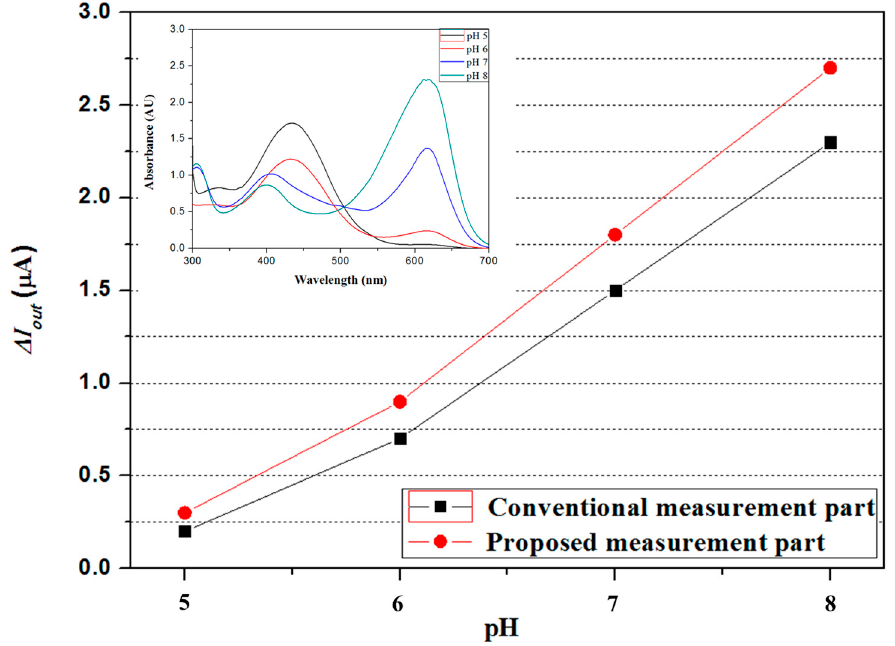
Figure 8. Comparison of the conventional measurement part and the proposed measurement part.